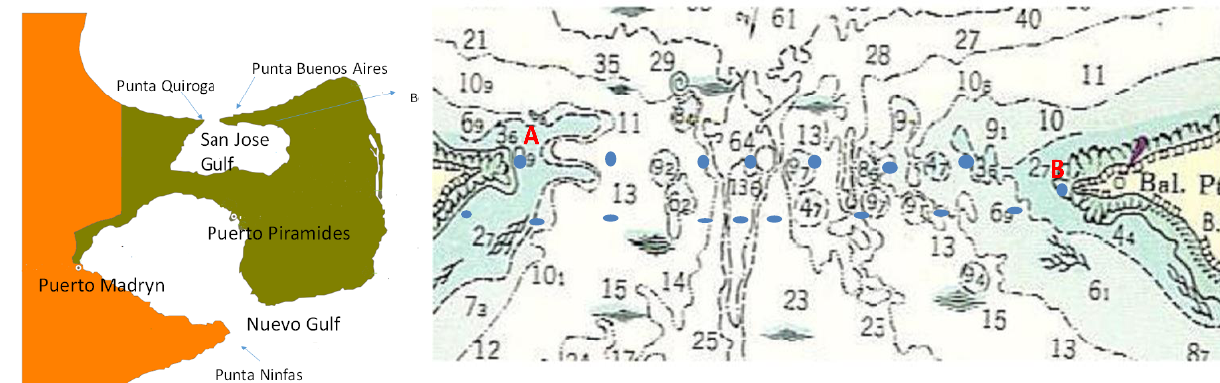
Fig. 3. Valdés Peninsula (Chubut). The Fig.4. San José Gulf entrance [35]. The letter A marks the western edge of the mouth dark brown area shows the Wildlife Reserve Punta Quiroga, and the letter B marks its eastern edge Punta Buenos Aires. The blue dots Area [29]. mark the points where the depths were registered for velocity